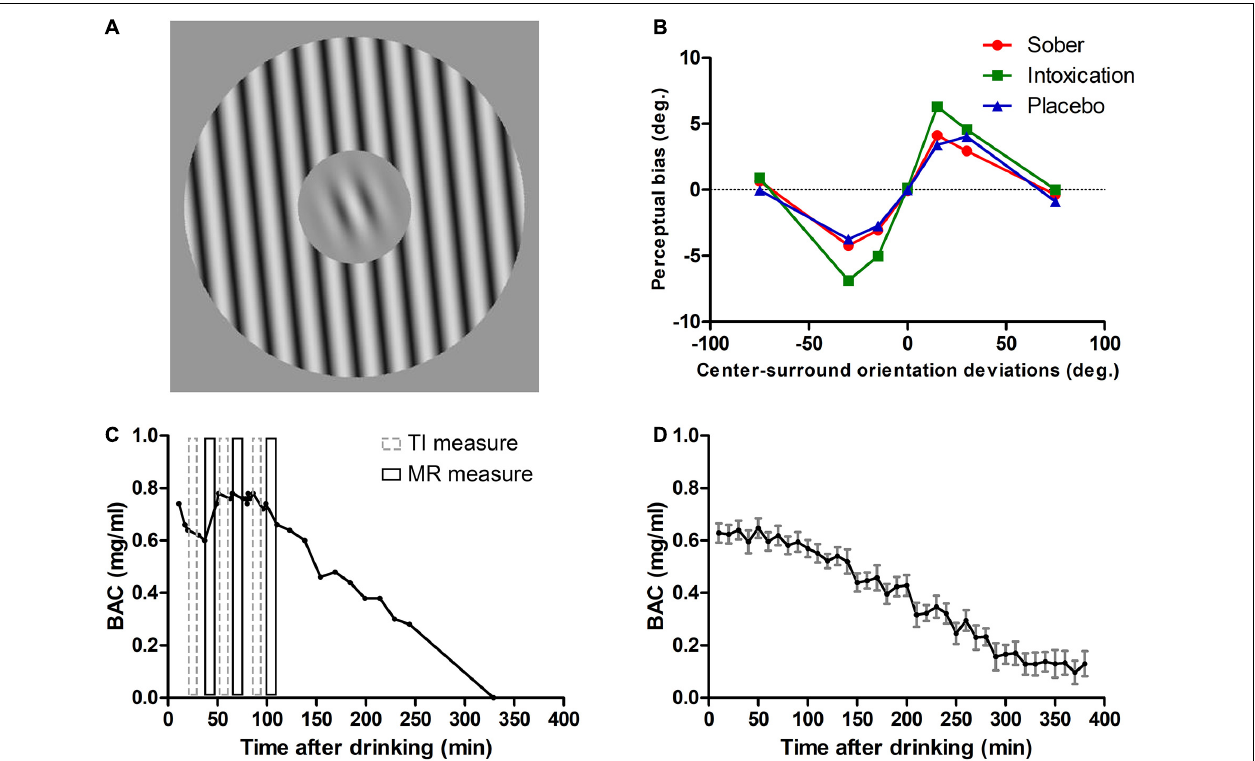
FIGURE 1 | Stimuli, TI results for one participant and profiles of alcohol metabolism. (A) TI measure was an orientation discrimination task. Stimuli have a center-surround configuration; the center Gabor target is surrounded by a grating annulus which could have an orientation of 0 ◦ , ± 15 ◦ , ± 30 ◦ , ± 75 ◦ with respect to the center Gabor (in the illustration it is +15 ◦ ). Participants were required to report whether the Gabor orientation was CW or CCW from the internal vertical. (B) Results of a participant. Tilt repulsion effects under sober (red solid line with filled circle), alcohol intoxication (green solid line with filled rectangle), and placebo (blue solid line with filled triangle) states. (C) BAC as a function of time after drinking for the same participant. Gray dashed rectangles represent the three TI measurements and black solid rectangles represent the three MR measurements. (D) Mean BAC curve across all participants (computed by pooling BAC values within 10 min bins). Error bars represent